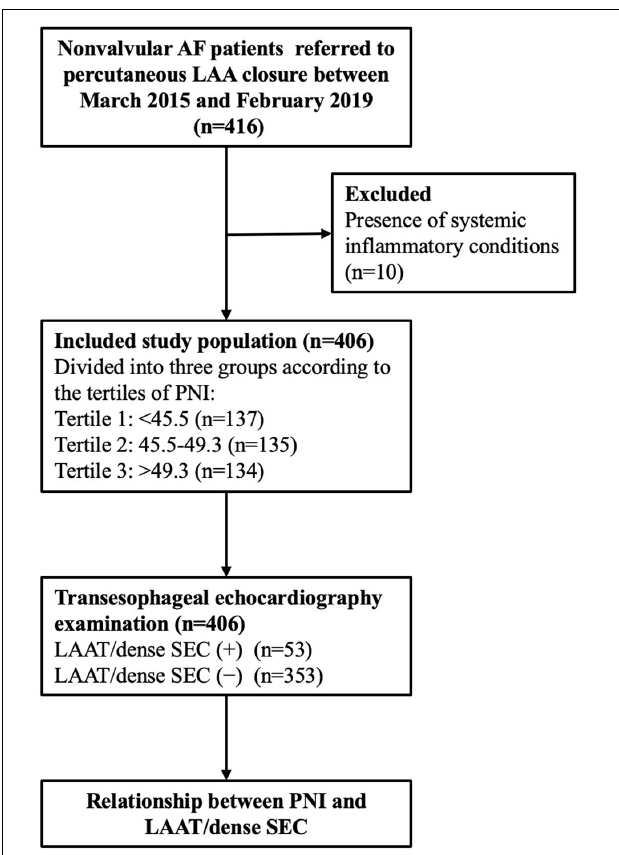
FIGURE 1 | Study flow chart. AF, atrial fibrillation; LAA, left atrial appendage; PNI, prognostic nutritional index; LAAT, left atrial appendage thrombus; SEC, spontaneous echo contrast.